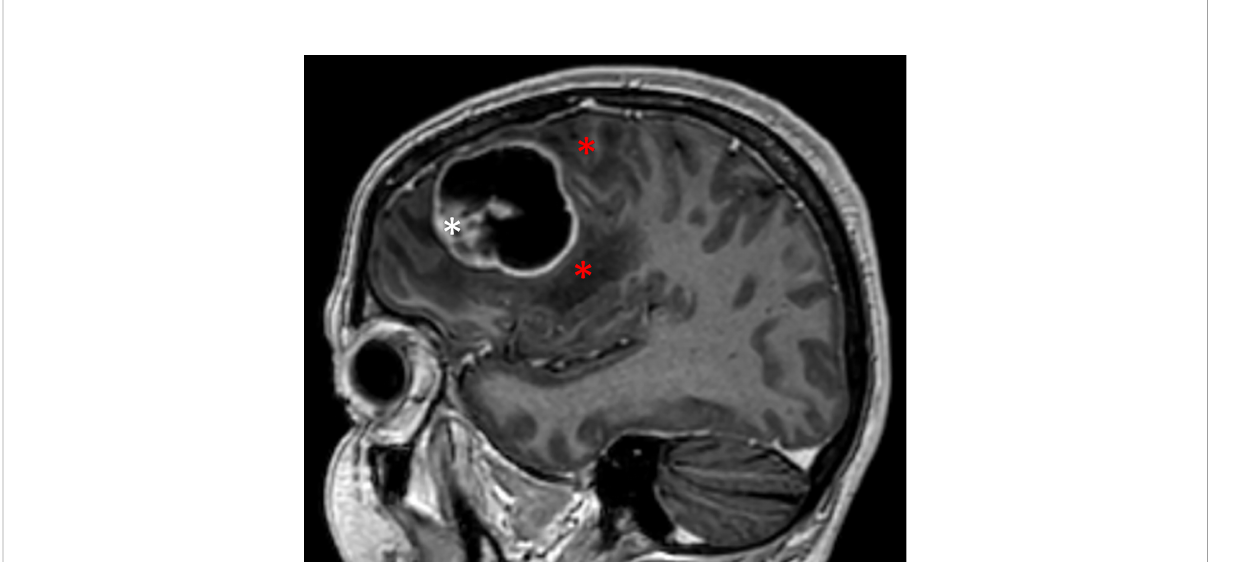
FIGURE 1 Cystic glioblastoma. Note how the cyst is in close contact with tumor tissue (white asterisk) and the surrounding brain tissue, both white matter and overlying neocortex. Red asterisks indicate the zone of peri-tumoral